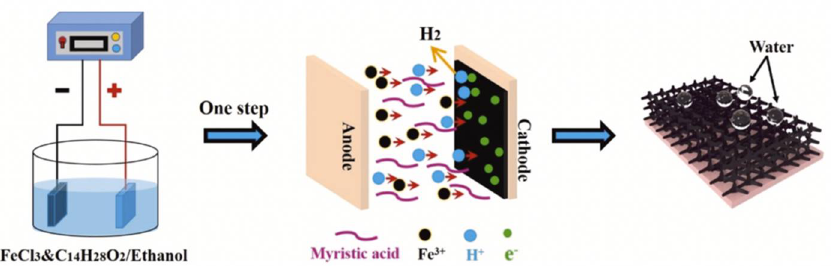
Figure 15. The formation process and mechanism to prepare the superhydrophobic surface on the copper surface. Reprinted with permission from Ref [72]. Copyright 2021 Elsevier.